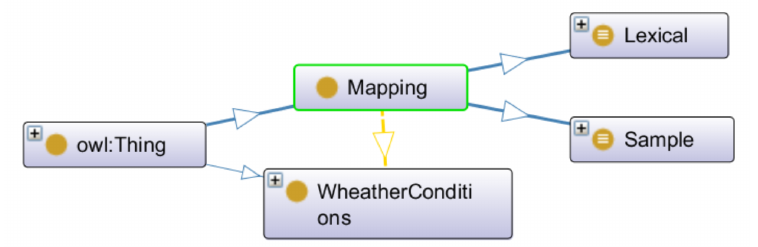
Figure 11. First ontology defined for the Mapping module (Protégé